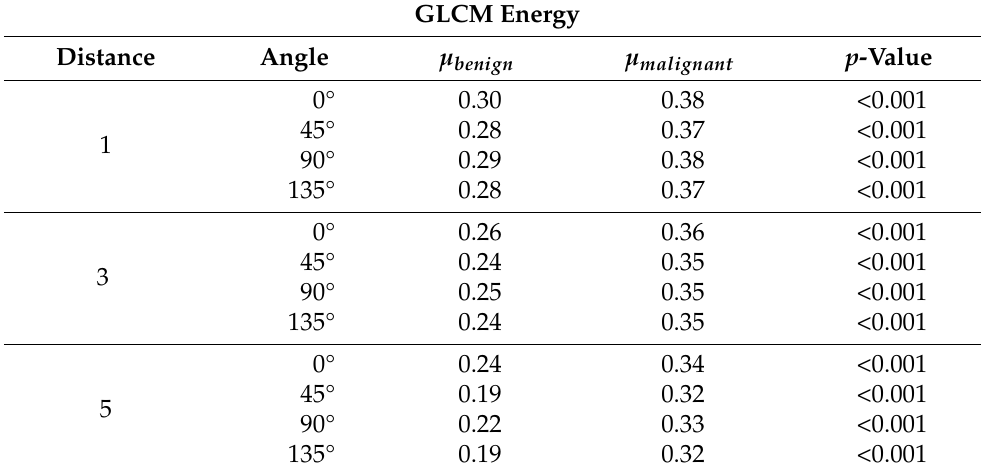
Table A6. The gray level co-occurrence matrix energy feature measured across three pixel distances